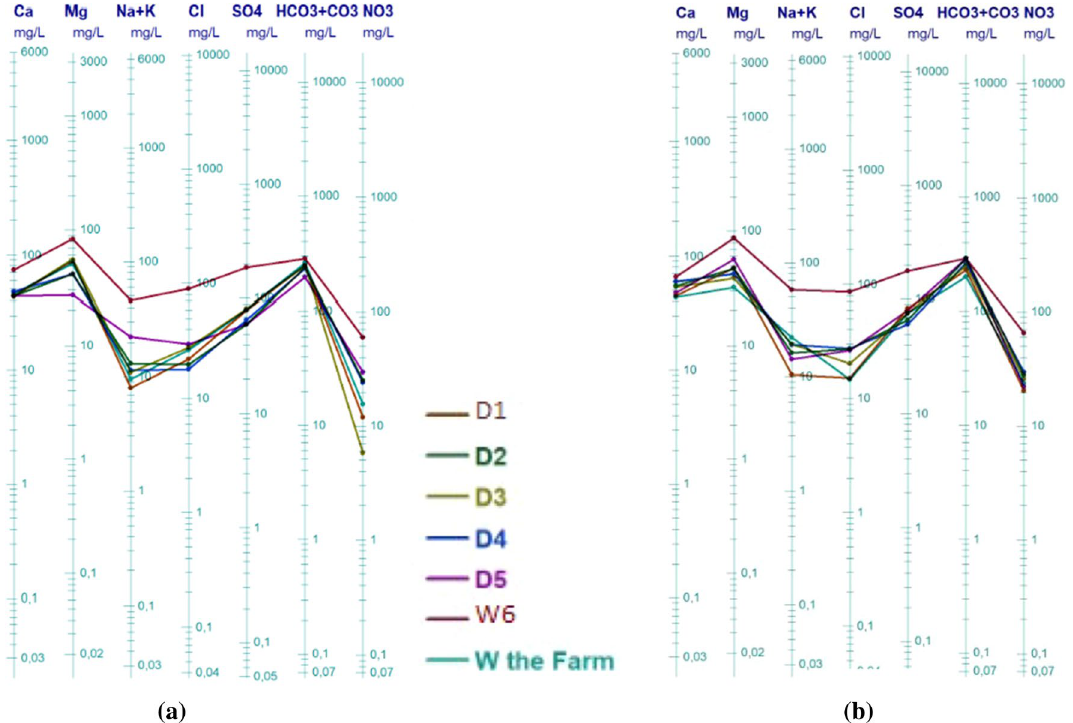
Fig. 2 Schöeller–Berkaloff analysis diagram for 2009 and 2019, using the Diagram software of the Avignon Hydrogeology Laboratory (Roland Simler 2003–2019) version